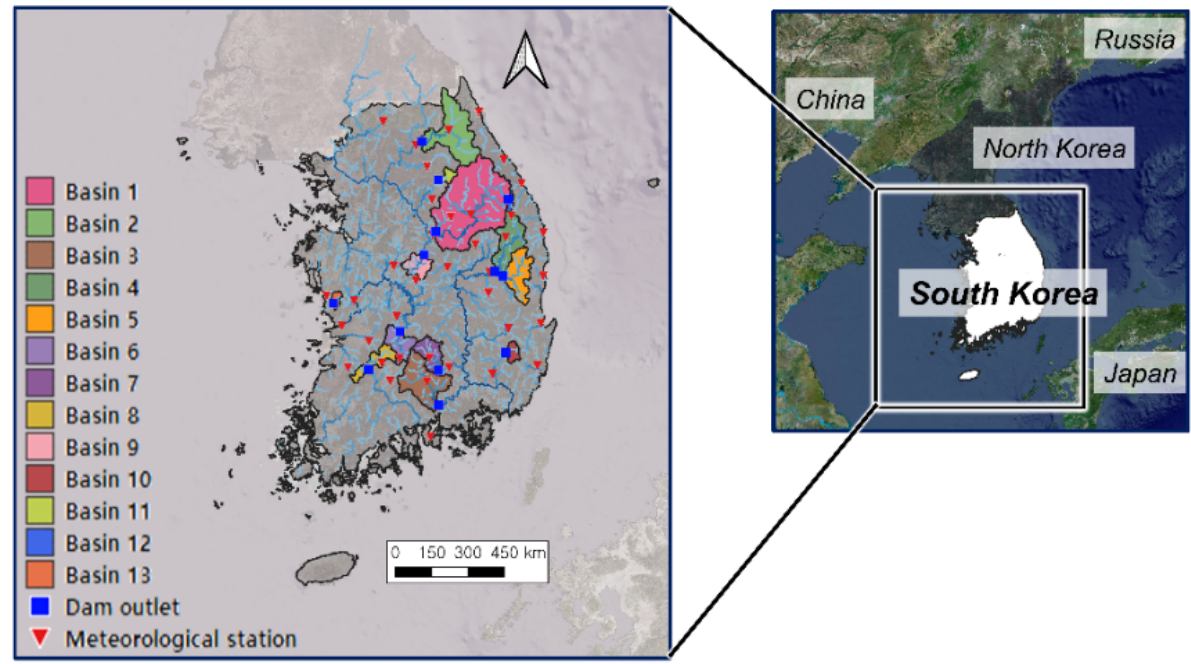
Figure 2. Locations of study basins. Here, red markers on the map denote the location of meteorological stations, and blue markers denote the dams.